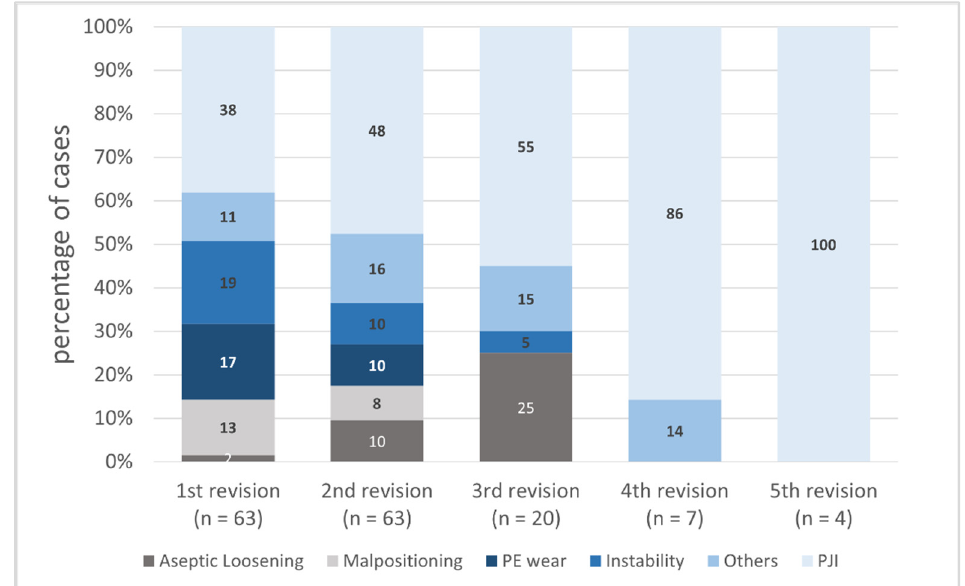
Figure 3. Distribution of revision reasons over the number of changes. PJI = periprosthetic joint infection. PE = polyethylene. Table 1. Reason for re-revision depending on previous revision indication.